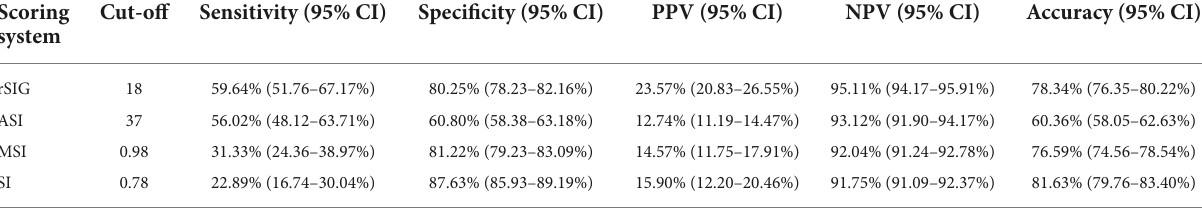
TABLE 4 Performance of scoring systems in prediction of mortality.